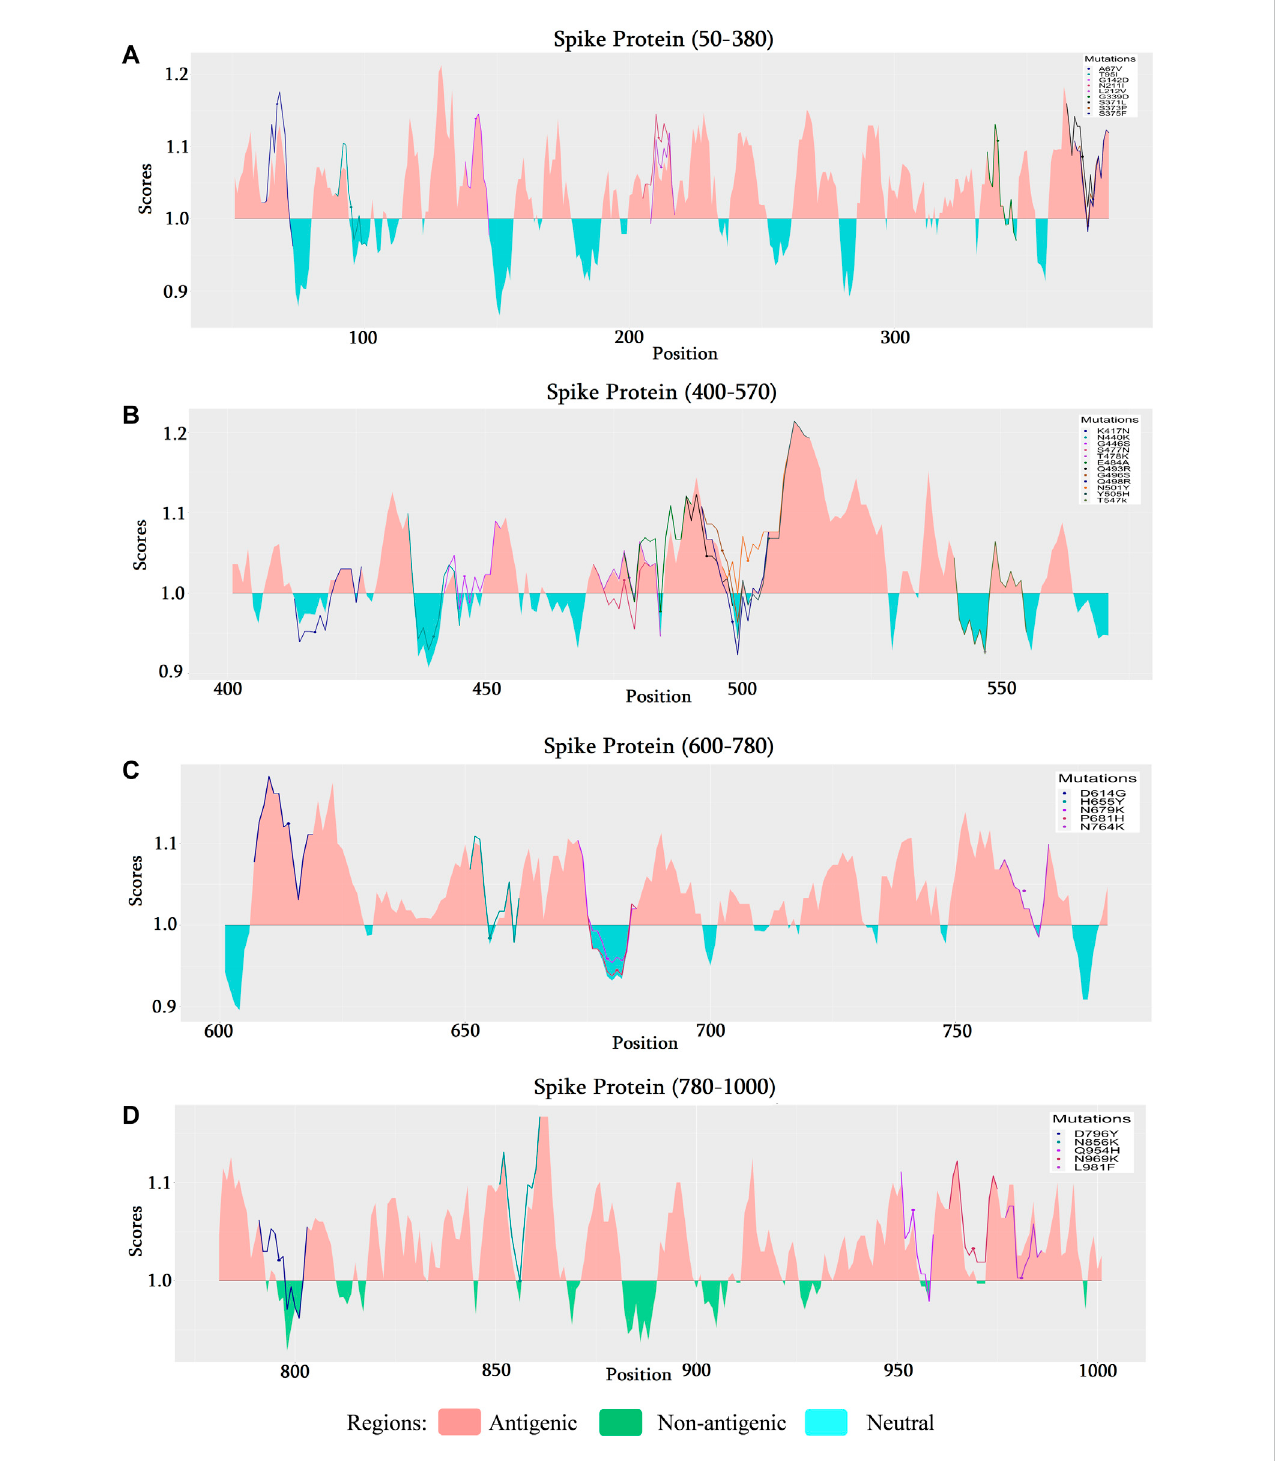
FIGURE 6 Comparison oftheBcellepitopeforspike(S)proteinofSARS-CoV-2omicronvariant. (A) Bcellepitopepredictionscorefrom50to380aminoacids(aa) of the S protein. (B) B cell epitope prediction score from 400 to 570 aa of the S protein. (C) B cell epitope prediction score from 600 – 780 to 900 aa of S protein. (D) B cell epitope prediction score from 780 to 1000 aa of the S